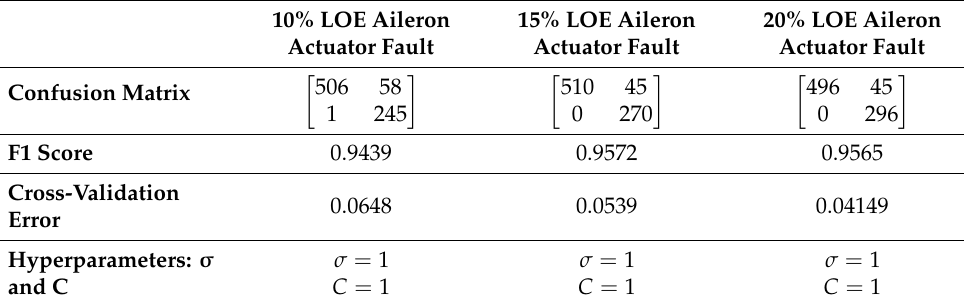
Table 4. Untuned SVM aileron results for LOE fault